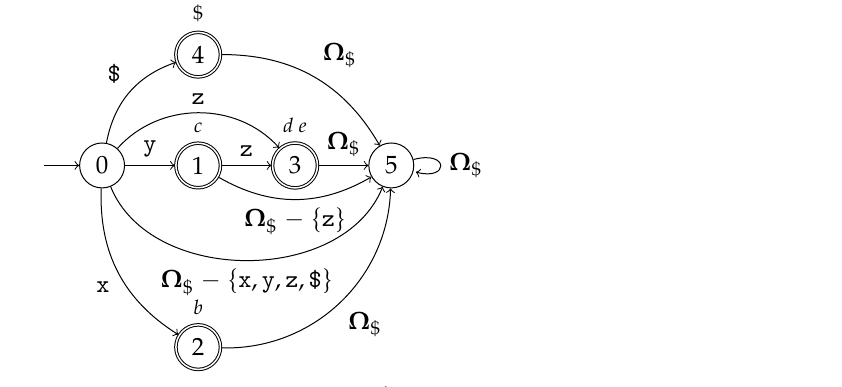
Figure 11. The scanner automaton 9 M T